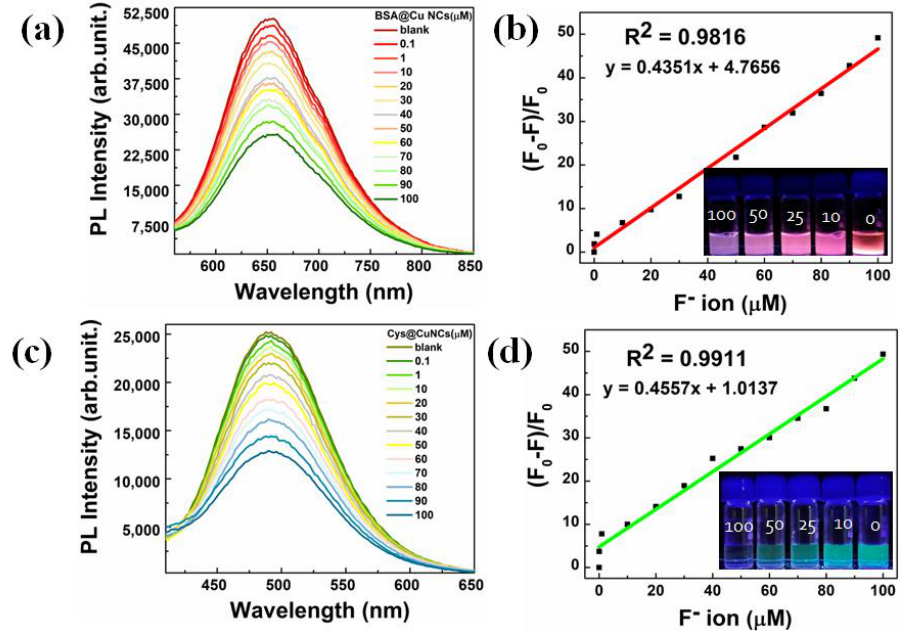
Figure 5. The change in the fluorescence intensity and the radiative decay patterns were measured with two different color-emitting Cu NCs in the presence of various anions at 0.1 M concentrations. ( a , b ) BSA-Cu NCs and ( c , d ) Cys-Cu NCs.